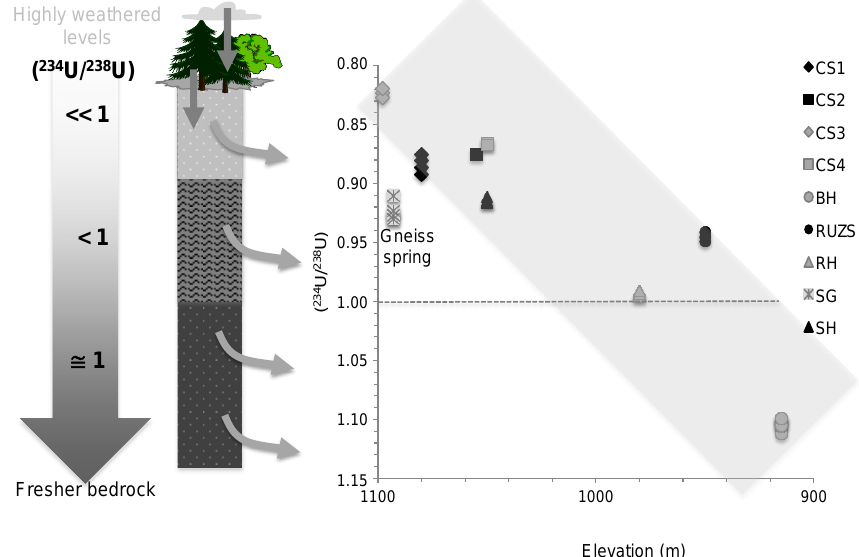
Figure 9. ( 234 U / 238 U) AR of springs vs. elevation. The U AR increase with decreasing altitude at the catchment